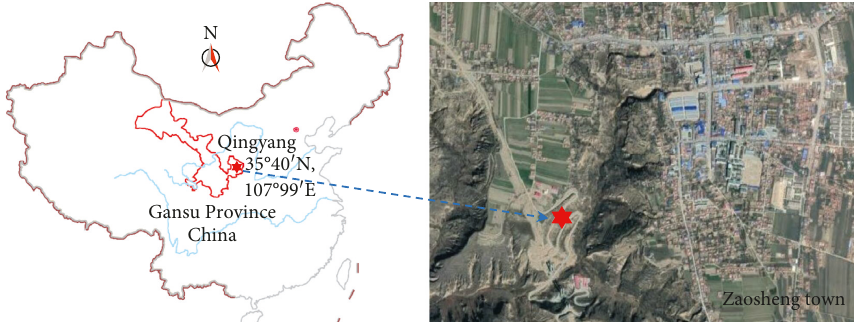
Figure 3: Geological location of the undisturbed loess soil.